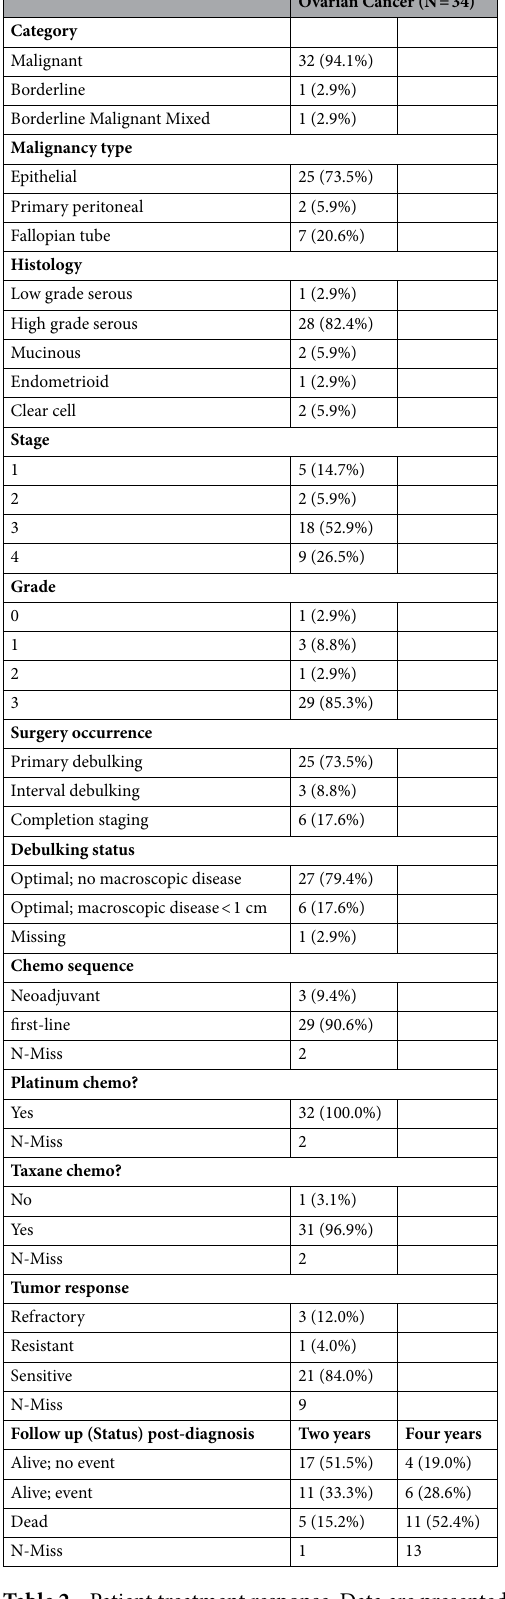
Table 2. Patient treatment response. Data are presented as count (percent). N-Miss, number of missing